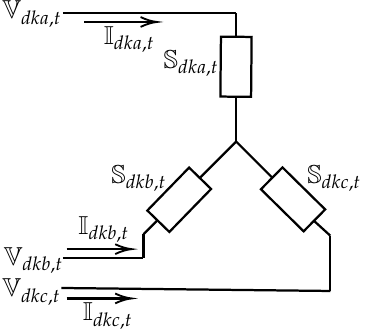
Figure 1. Three-phase load connected in the node k in Y .